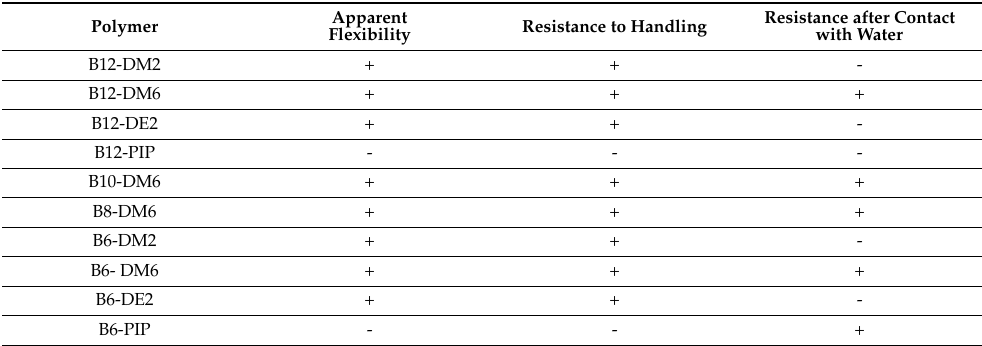
Table 7. Preliminary evaluation of the effect of water contact on the macroscopic properties of H-PAA films (~20 ◦ C).